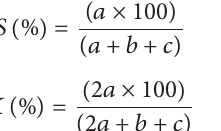
Figure 3: Cartography of land use change inside study’s